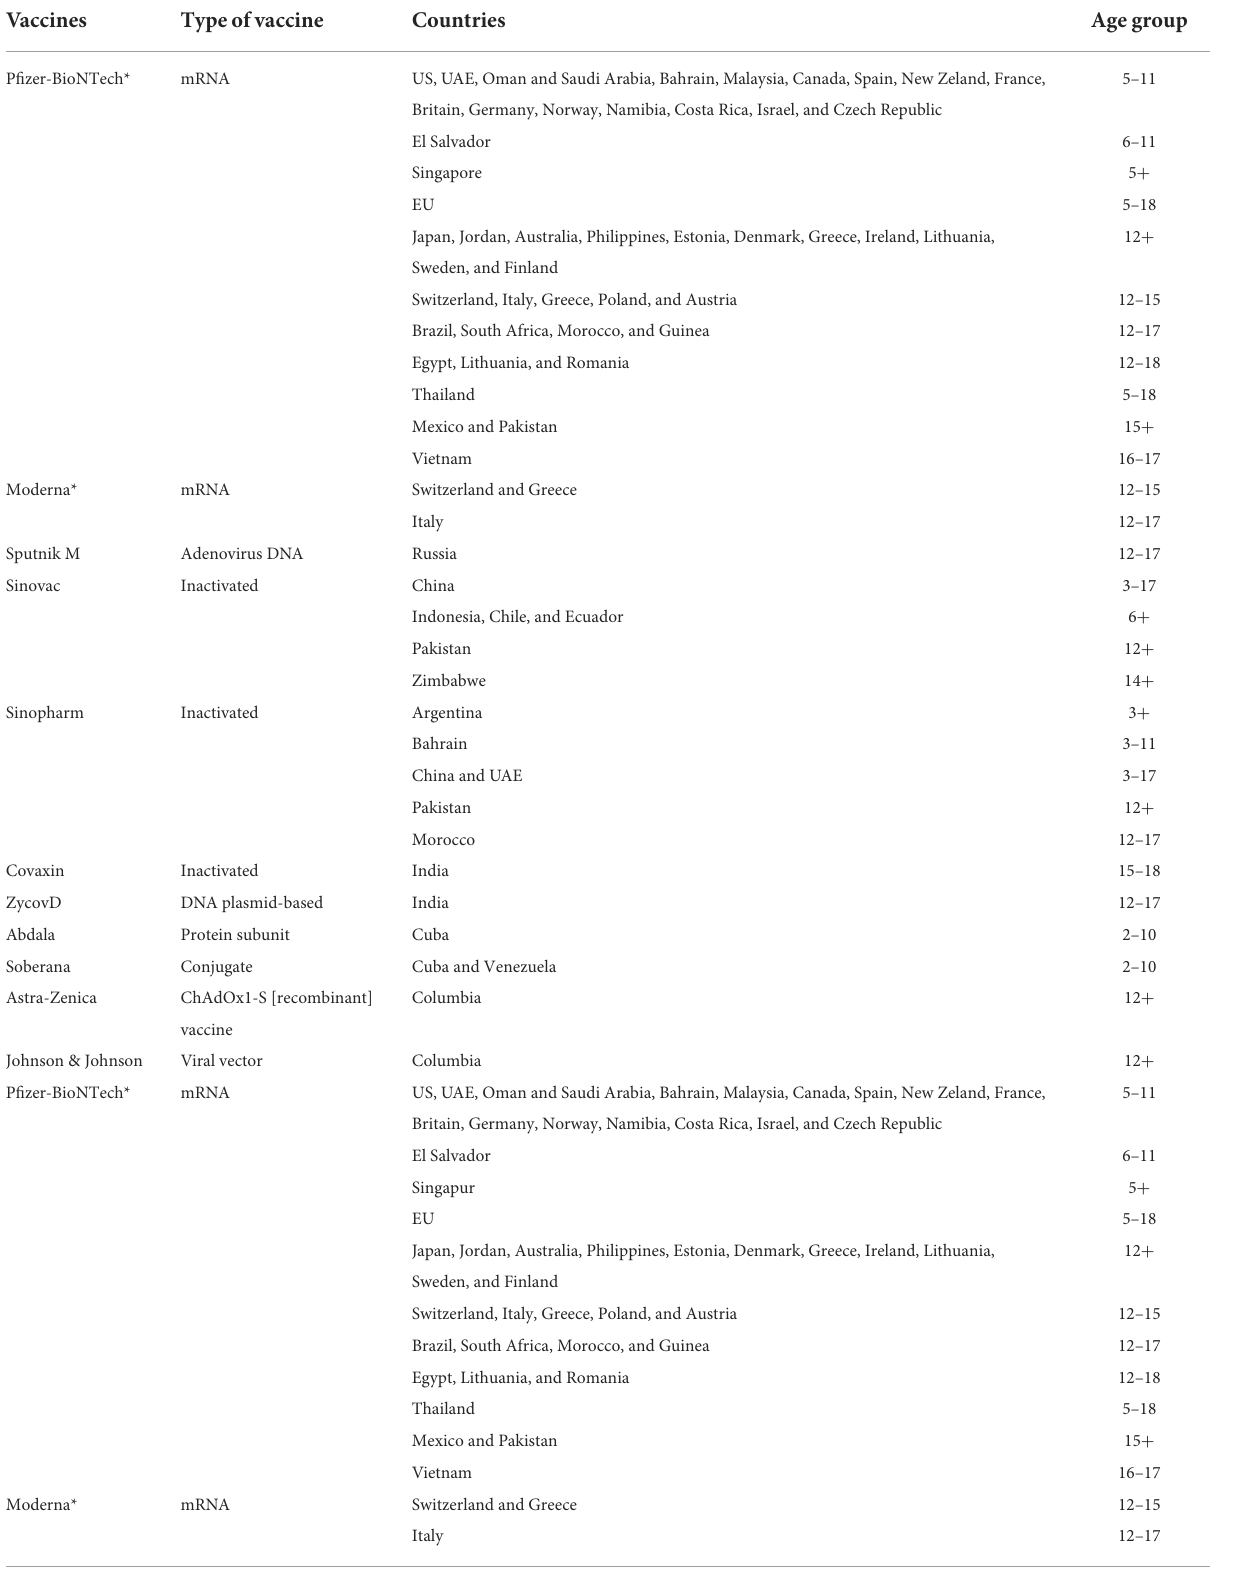
TABLE 1 Vaccines approved for administration in children in different countries